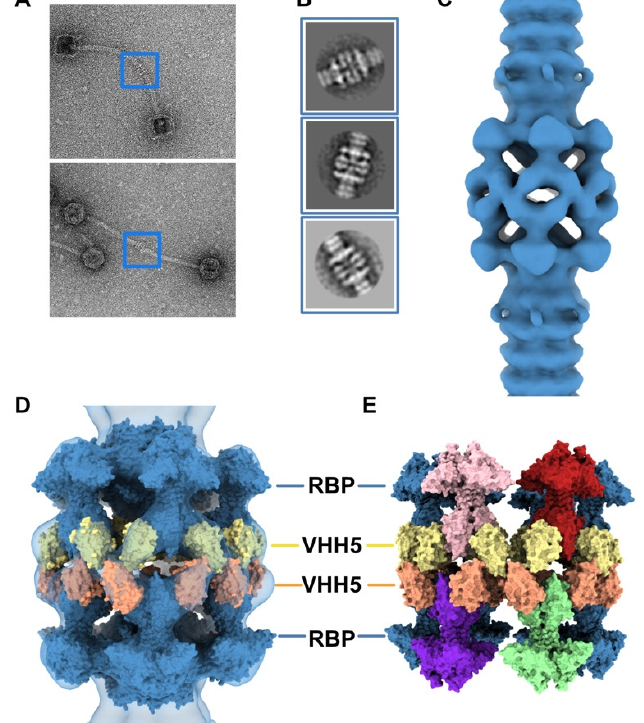
Figure 4. 3D reconstruction of activated baseplate in VHH5-bound p2 virions. ( A ) Representative phage p2 virions in complex with VHH5 (virion-virion assembly) observed in micrographs. Baseplate-baseplate assemblies (blue boxes) were selected for image processing. ( B ) Representative 2D classes of baseplate-baseplate assemblies. ( C ) 3D reconstruction of p2 tail tip and baseplate complexed with VHH5 and forming a dimer (EMD-11226). The map is contoured at 2.5 σ . ( D ) Surface representation of the p2 baseplate in its activated conformation (RBPs pointing in the direction opposite to the capsid) (PDB ID 2X53, blue), fitted in the map. Surfaces of VHH5 (PDB ID 2BSE [11]) in contact with the upper RBPs (yellow) and lower RBPs (orange) are also shown. ( E ) Surface representation of the VHH5-bound RBPs from the upper and lower baseplates as shown in D. Note that VHH5 in the upper baseplate (yellow) interact with VHH5 in the lower baseplate